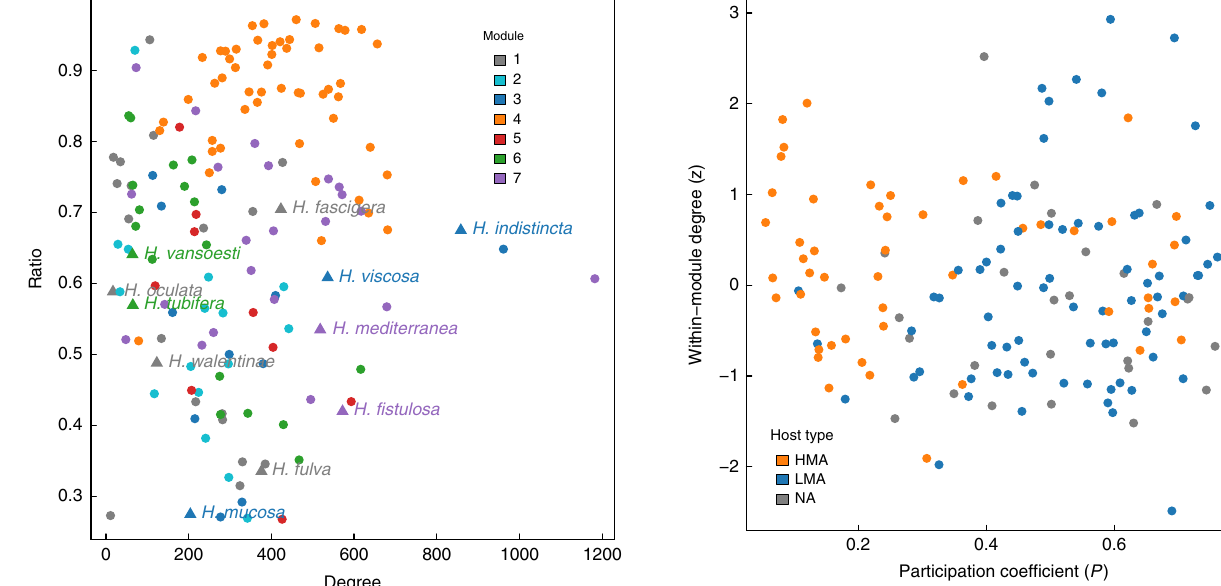
Fig. 3 Degree – ratio relationships for sponges in the core network. Degree (i.e. number of OTUs found within the host) vs. ratio of within- module links vs. across-module links of the sponge species in the sponge core – microbiome network, based on the core microbiome modularity. Each point corresponds to a sponge species. Different colours represent species memberships in the modular classi fi cation. Haliclona species are highlighted (with species name and a triangle) to illustrate the degree of heterogeneity, both in terms of OTUs and the degree of their intra-module connectivity, among low-microbial abundance species from the same genus